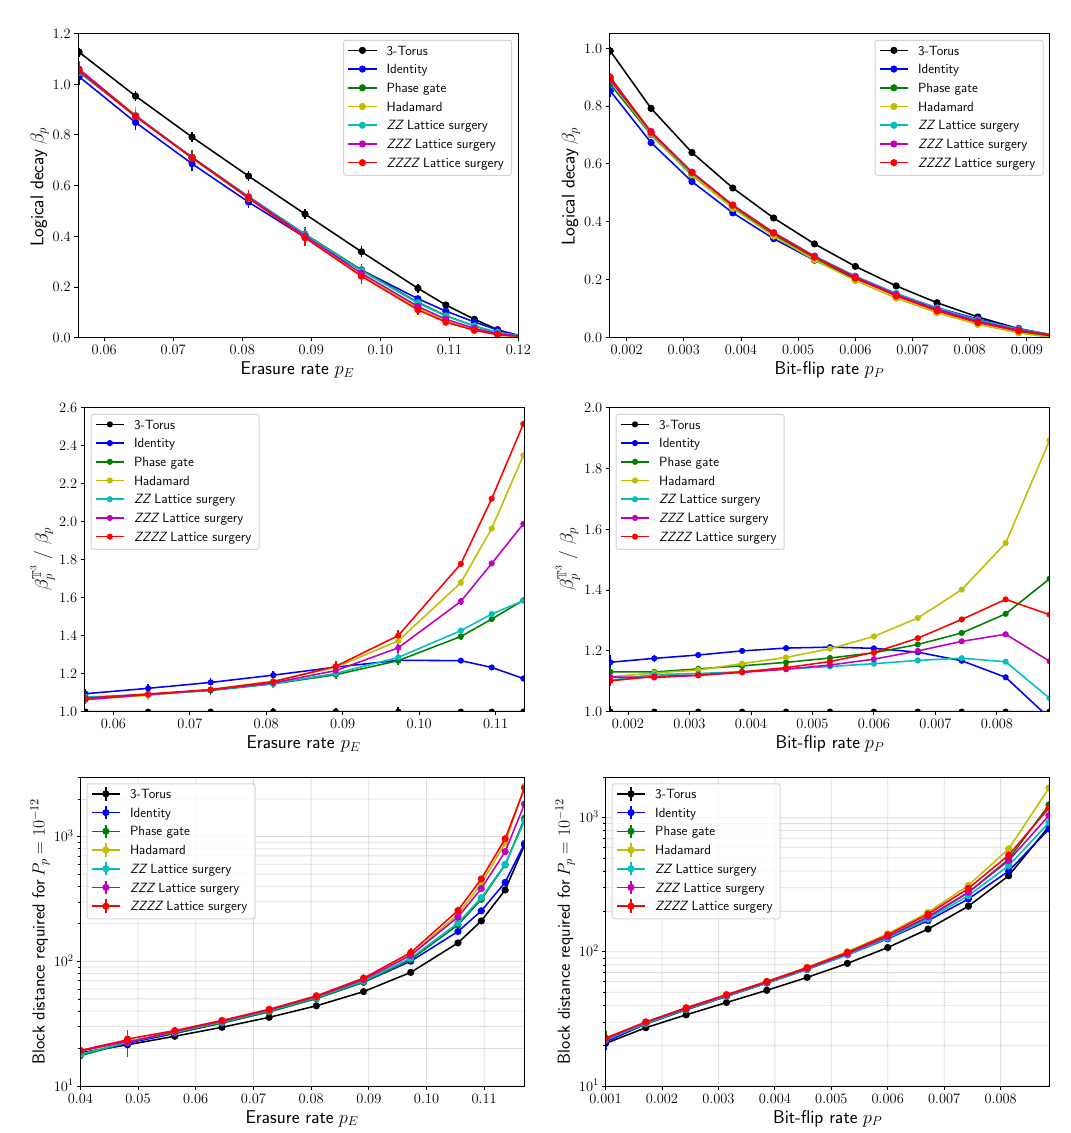
FIG. 18. Top: fits of β p to the logical block error rate P p ( d ) = α p e − β p d under IID erasure and IID bit-flip noise models for the identity, 3-torus, phase, Hadamard, and multiqubit lattice surgery blocks. Each data point is obtained by performing 10 9 to 10 10 decoder trials for each block distance and physical error rate, with block distances up to 14. Error bars correspond to uncertainty in the fit, as described in Appendix A 11. The 3-torus has the largest logical decay out of the simulated blocks, including the identity block—meaning that in the case of memory the toric code has better error suppression than the planar code. Furthermore, the logical decay β p for lattice surgery is independent of the number of logical qubits involved for sufficiently low physical error rates. Middle: /β β T 3 is the logical decay for the 3-torus. This ratio plots of β T 3 p against the physical error rate for different logical blocks, where p p determines how much larger a given block distance must be, compared to the 3-torus, to achieve the same logical error rate scaling. Bottom: the block distance d required to achieve a target logical error rate of P p = 10 − 12 per block as a function of physical error rate p for both erasure and bit-flip physical errors. The distances required can become very large near threshold, and as such, it is important to be significantly below threshold to have reasonable fault-tolerance overheads. In all plots, lines are guides for the eye. physical error rate. In Fig. 18 we display estimates for the required distance based on numerical fits for α and p β . For concreteness, we choose a target logical p